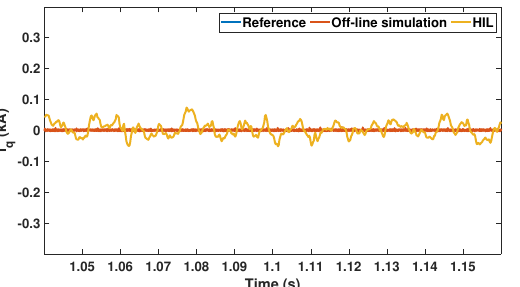
Figure 20. Experimental results of proposed method subjected to grid frequency change: () i q